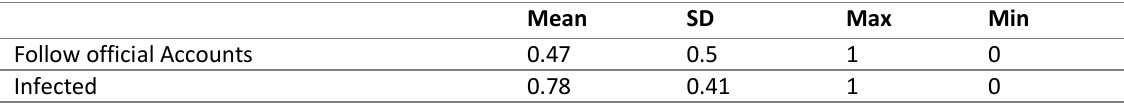
Table 4. Descriptive statistics. Mean, standard deviation (sd), maximum and